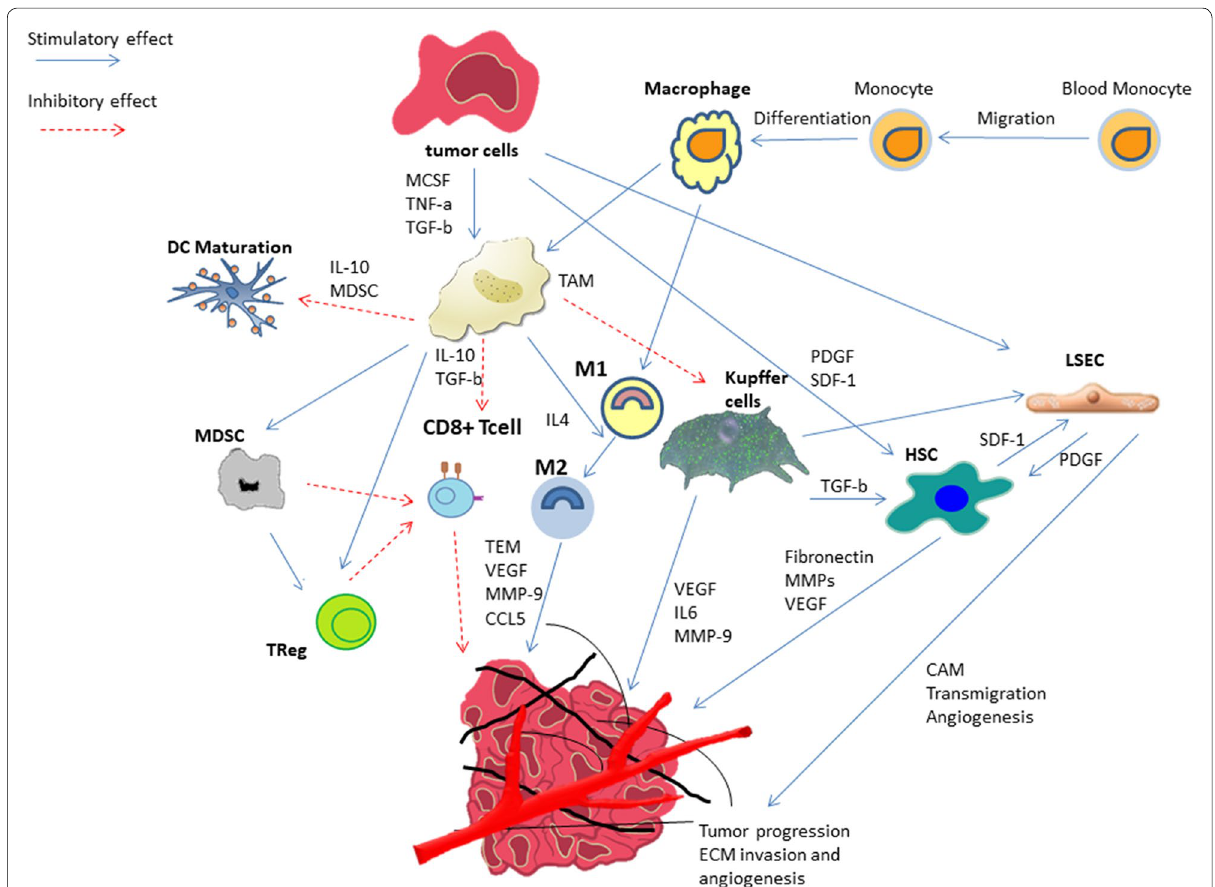
Fig. 1 Cellular factors playing role in formation and development of metastatic niche within liver microenvironment. This figure depicts the schematic representation of the major cellular components involved in a multistep process in the formation and development of the metastatic niches in the liver microenvironment. ( TEM transendothelial migration, MMP metalloproteinases, CCL5 chemokine ligand